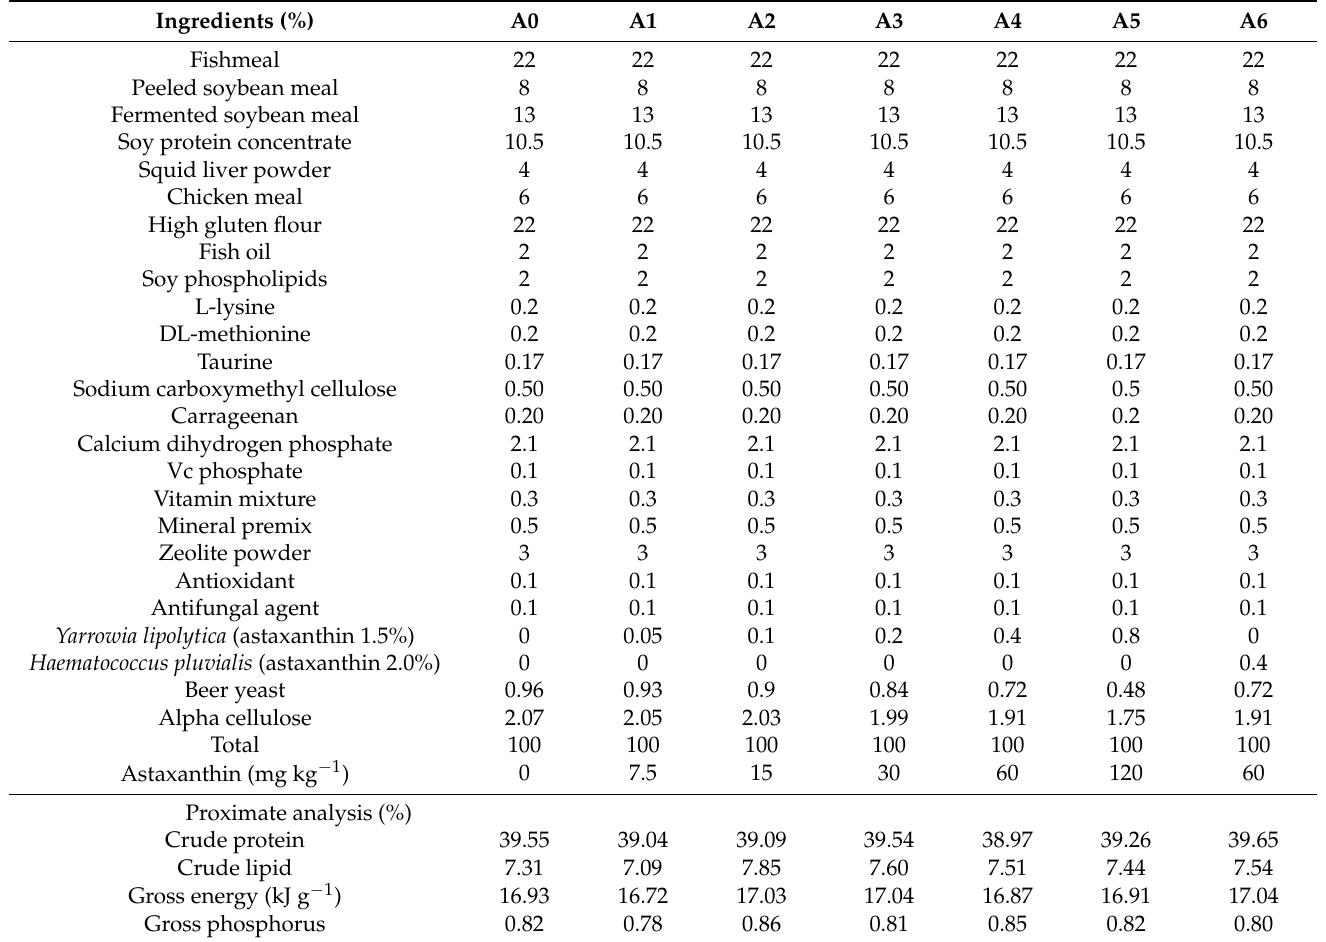
Table 1. Formulation and proximate composition of the experimental